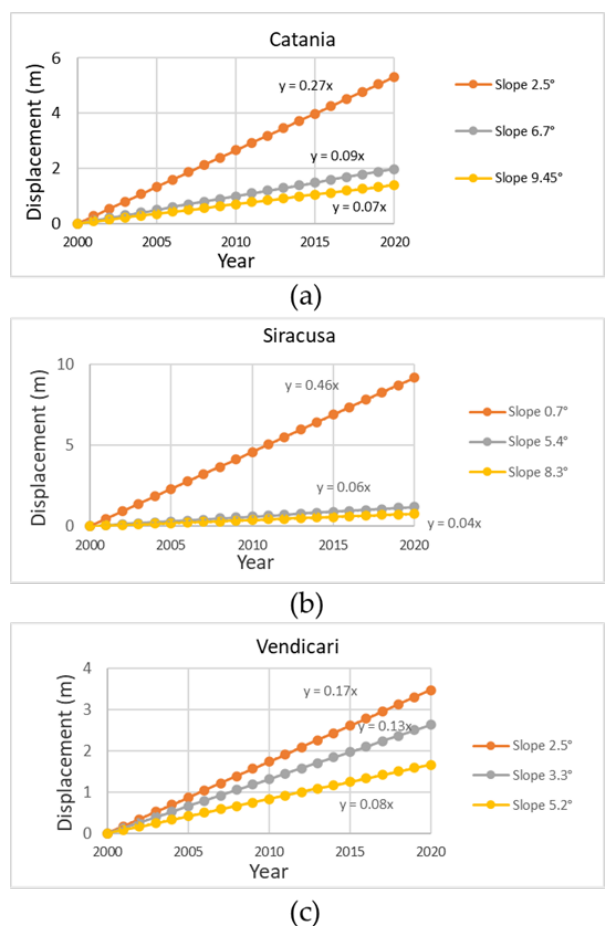
Figure 8. ( a – c ) Horizontal displacements obtained following a geometric steady-state approach: sea-level rise determines a landward shoreline movement without accretion, where the shoreline rate change is dependent only on the coastal slope extracted from the DEM of LiDAR data.